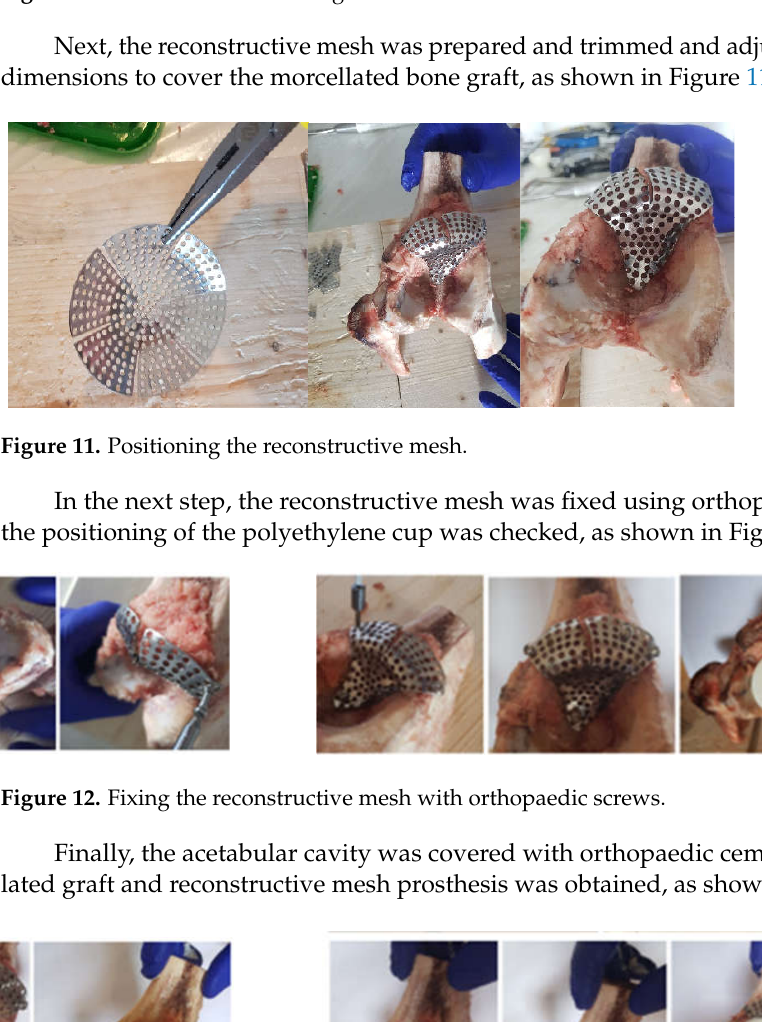
Figure 10. Placement of the bone graft.